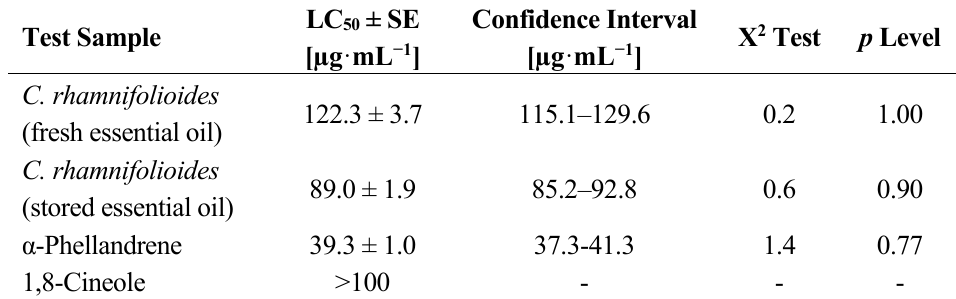
Table 2. Larvicidal activities of fresh and stored samples of essential oil of Croton rhamnifolioides and their major